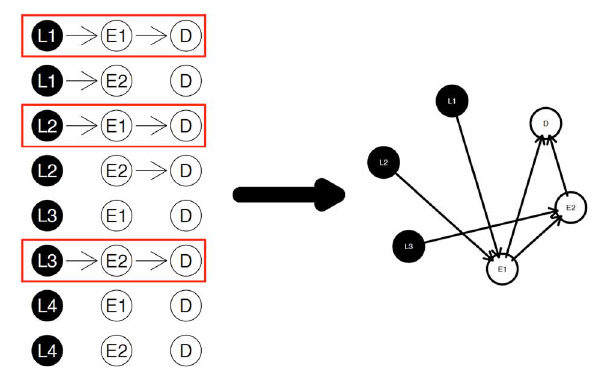
FIGURE 2 | The three steps in the nPARS algorithm: (1) constructing three-node subnetworks, (2) select subnetworks, and (3) reassemble into larger networks.